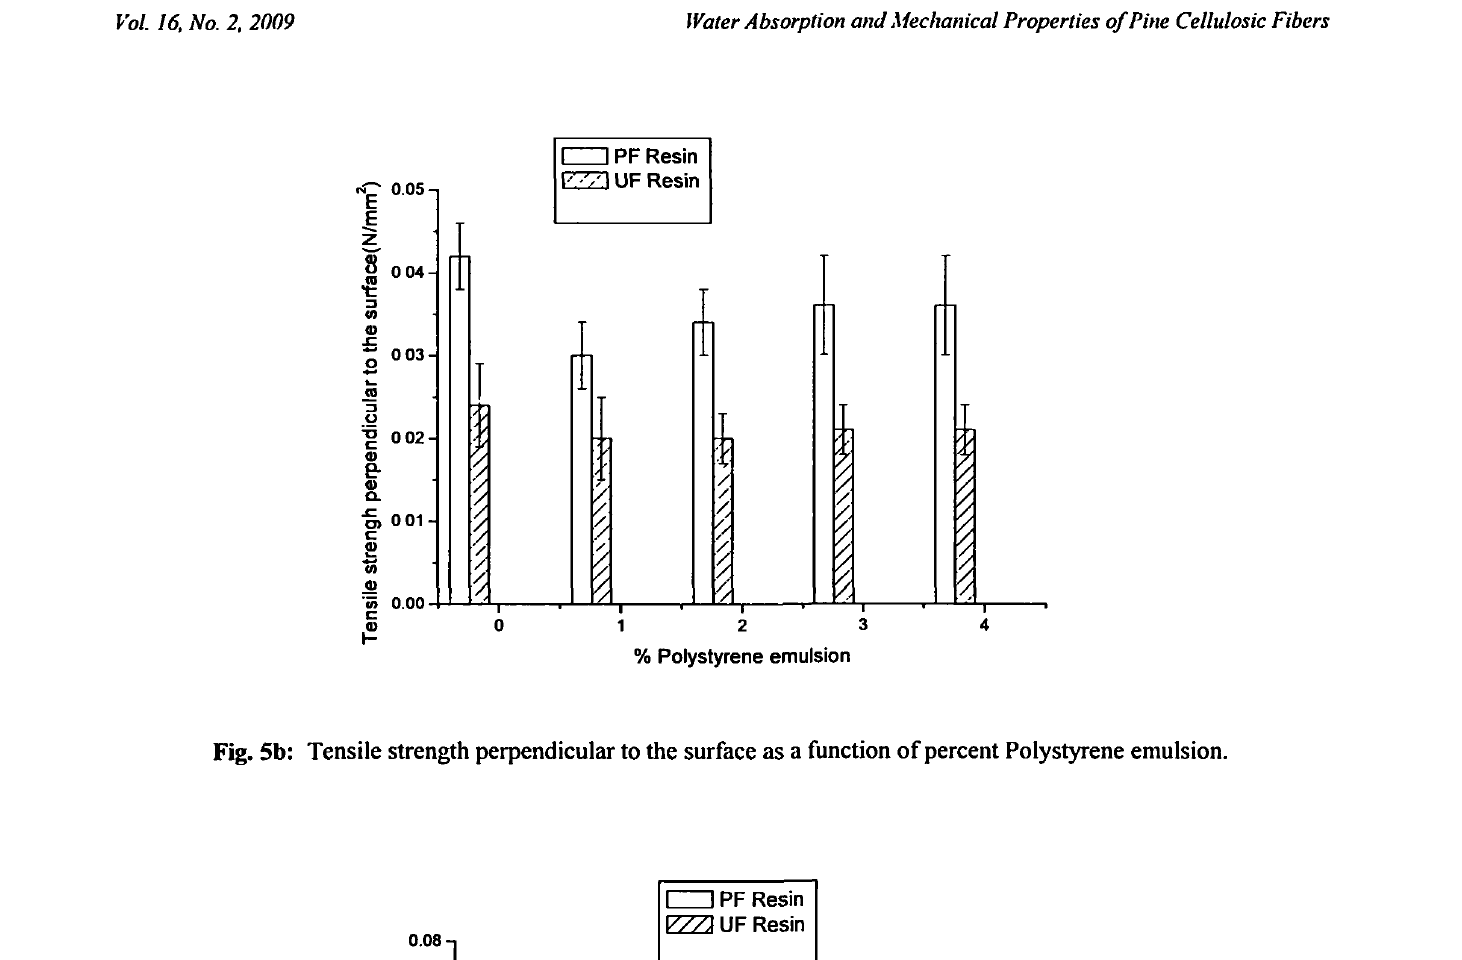
Fig. 5b: Tensile strength perpendicular to the surface as a function of percent Polystyrene emulsion.